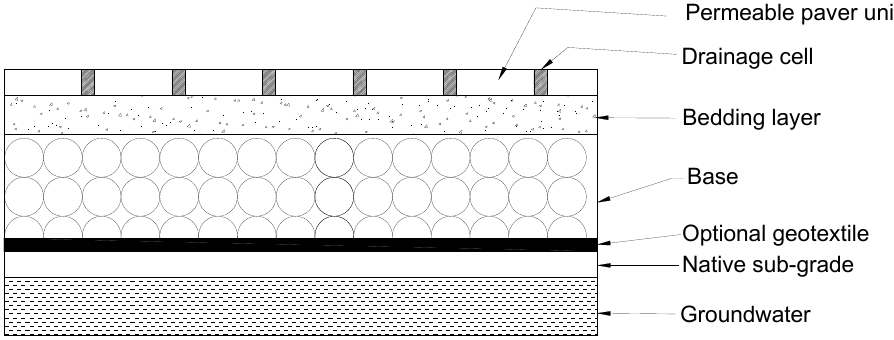
Figure 1. Schematic outline of the main design components of a permeable pavement